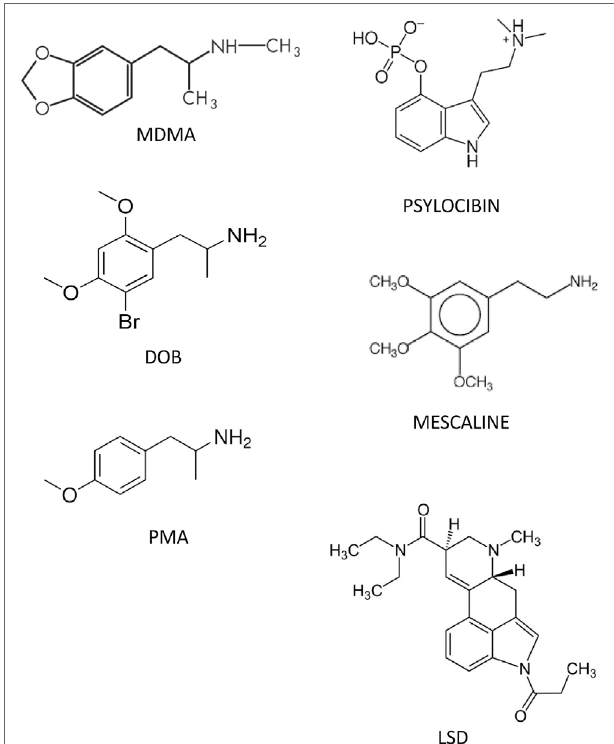
FigUre 1 | Structures of some of the phenetylamines used in the study and the main serotonergic